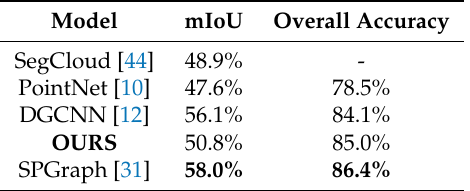
Table 5. Segmentation results on S3DIS Area 5.